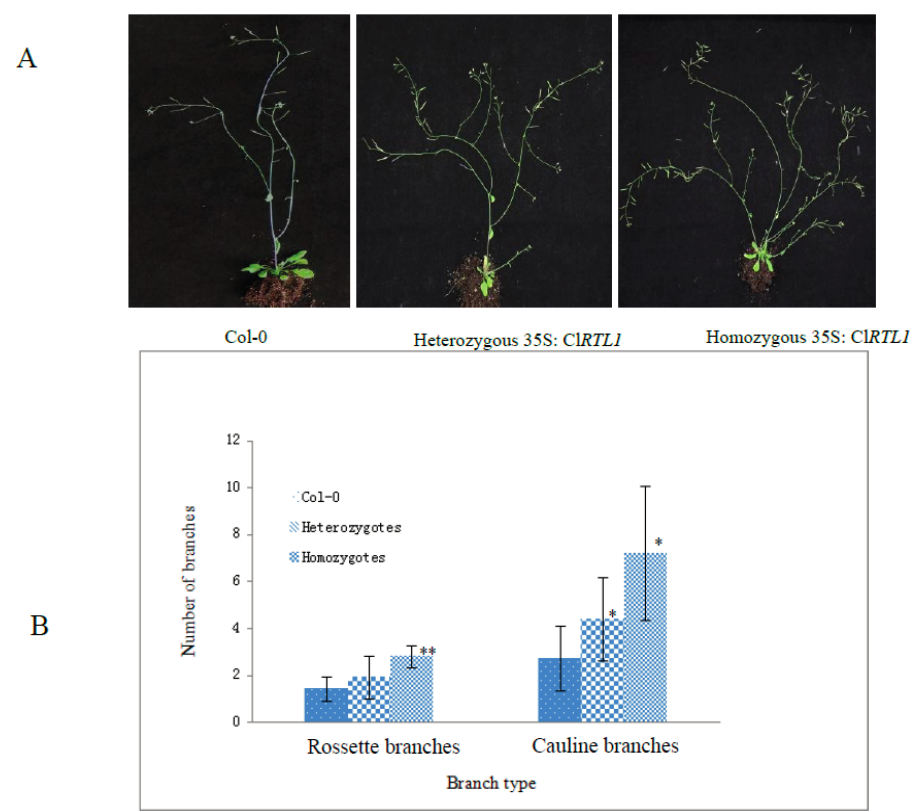
Figure 8. The increased shoot branching phenotypes of 35S : Cl RTL1 seedlings. ( A ) 35S : Cl RTL1 seedlings showing increased shoot branching (at four weeks after transplanting) Col-0: wild type A. thaliana (ecotype Columbia). Heterozygous 35S : Cl RTL1 seedlings which showed a higher number of cauline branches than wild-type plants. Homozygous 35S : Cl RTL1 seedlings which showed more severe phenotype with significantly higher numbers of cauline branches and rosette branches than wild-type plants; ( B ) Quantitative analysis of the secondary shoot development in 35S: Cl RTL1 seedlings. Rosette branches and cauline branches were counted at four weeks after transplanting. Error bars represent the standard errors of the means: n = 10–20. * p < 0.05, ** p < 0.01. Col-0: wild-type A. thaliana (ecotype Columbia); Heterozygotes: Heterozygous 35S: Cl RTL1 A. thaliana seedlings; Homozygotes: Homozygous 35S: Cl RTL1 A. thaliana